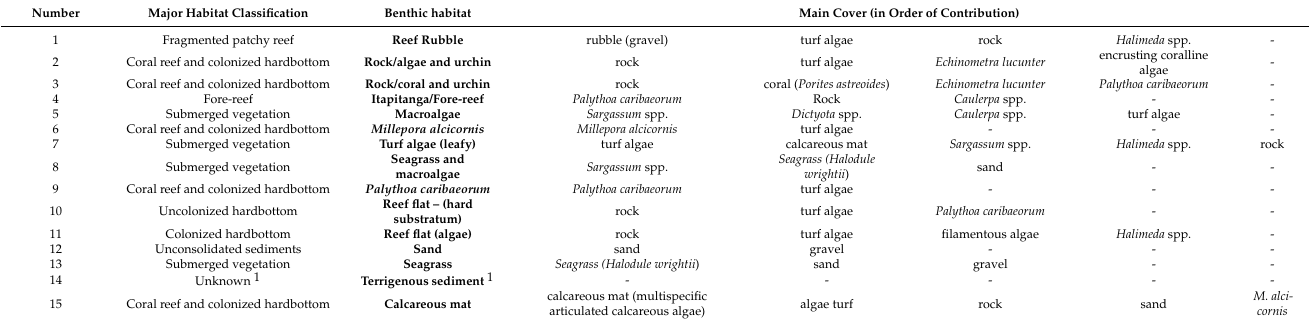
1 The marine habitat “terrigenous sediment” was only identified remotely (due to high sedimentation in the coastal area and on top of some reefs and thus the infeasibility of mapping the substrata correctly with satellite